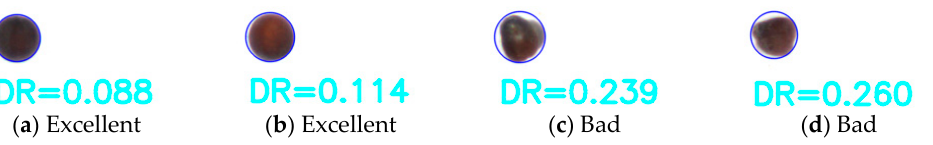
Figure 5. Defect ratio comparison . Figure 4. Circularity comparison.